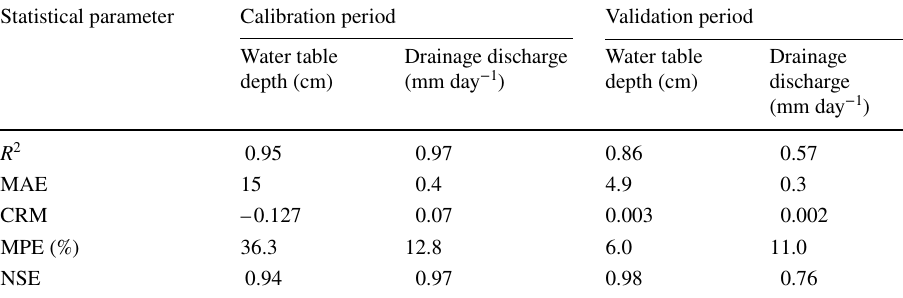
performance parameters in simulating WTD and DD during calibration and validation